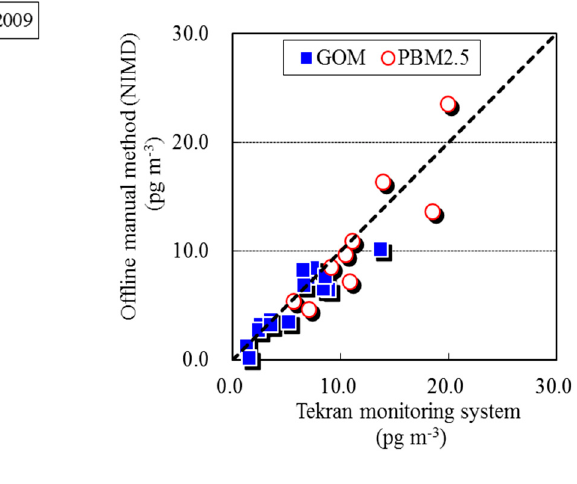
Figure 2. Scatterplots of the ( a ) gaseous elemental mercury (GEM) concentrations recorded using the Tekran monitoring system and the total gaseous mercury (TGM) obtained using the method outlined in the official Ministry of the Environment, Japan (MOEJ) manual and ( b ) gaseous oxidized mercury (GOM) and particle-bound mercury for particles with diameter smaller than 2.5 μ m (PBM 2.5 ) concentrations recorded using the Tekran monitoring system and the offline method.